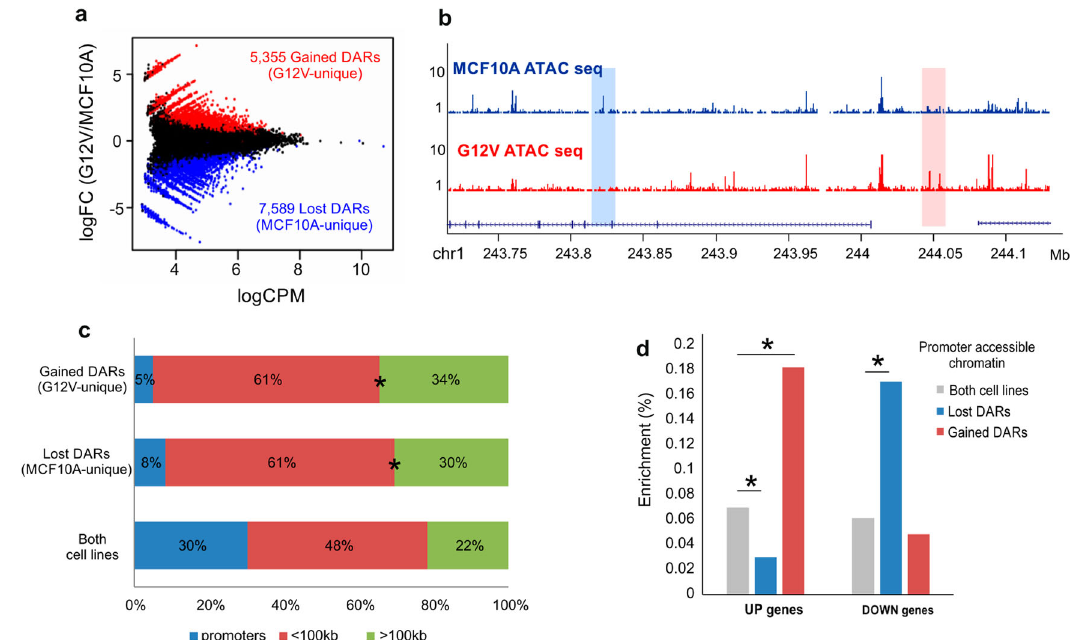
Fig. 3 G12V HRas induced changes in the transcription regulatory landscape. a MA plot displaying the mean normalized counts (Counts Per Million (CPM), x -axis) versus the log 2 fold change between MCF10A and G12V cells ( y -axis), of the ATAC seq peaks. Red and blue points represent unique G12V (gained DARs) and unique MCF10A peaks (lost DARs), respectively, as declared by MACS analysis. b Representative examples of lost (blue box) or gained (pink box) DARs. Chromosomal coordinates in Mb of human hg19 genome build are indicated at the bottom. c Distribution of regulatory sites relatively to genes: promoter-proximal ( + 500 bp, − 1000 bp from the gene ’ s transcription start site (TSS), blue), mid-range (±100kb, red) and far-range (green) in gained or lost DARs or accessible regions shared by both cell types. * p < 0.001, proportional test. d % of regulatory sites near promoters of up-regulated genes in G12V cells (UP genes) or down-regulated genes in G12V cells (DOWN genes) from total regulatory sites near promoters. * p < 0.001, proportional